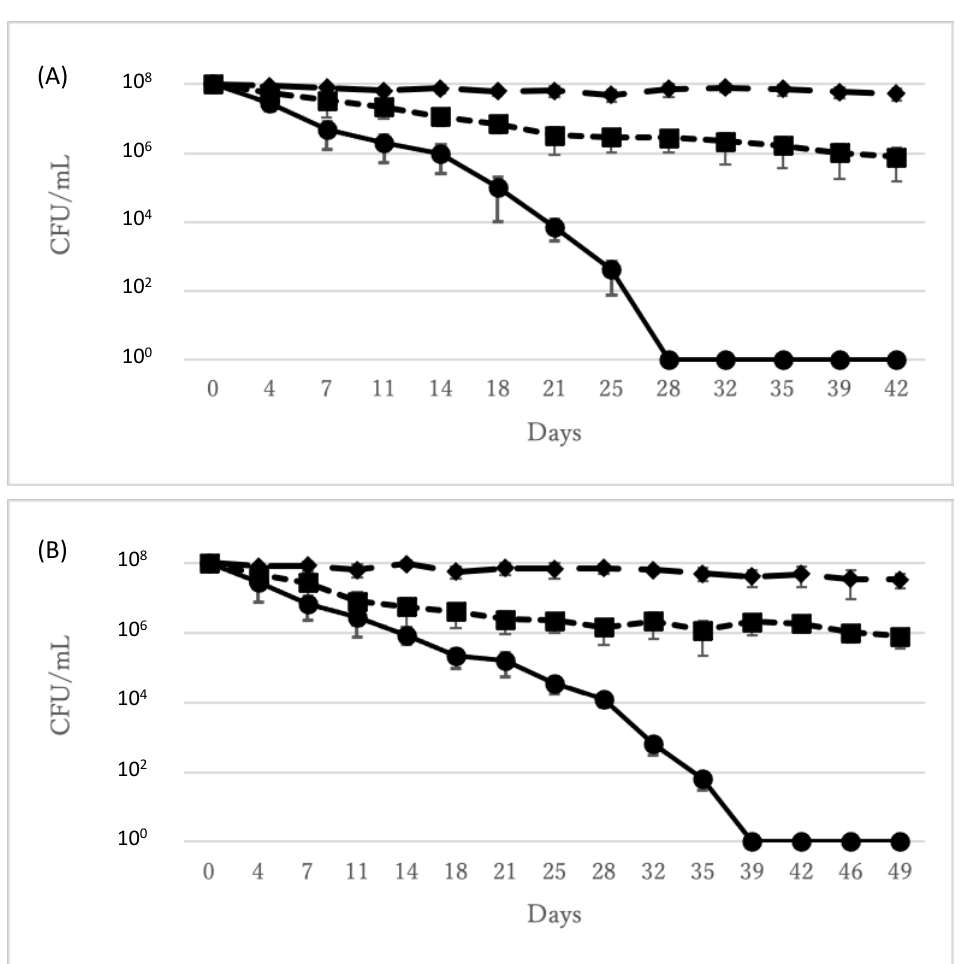
Figure 1. The number of total (rhombus and long broken line), viable (square and short broken line), and culturable (circle and full line) C. diphtheriae ATCC700971 ( A ) or ATCC27010 ( B ) over time. Error bars represent the mean ± S.D. from three independent